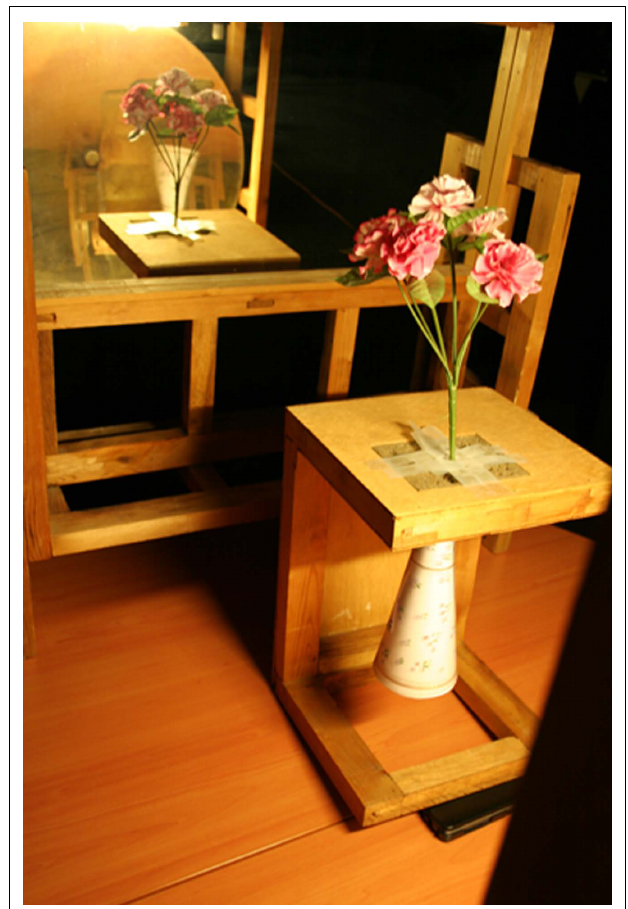
FIGURE 4 |The projection of a virtual vase around real flowers in Lacan’s double-mirror